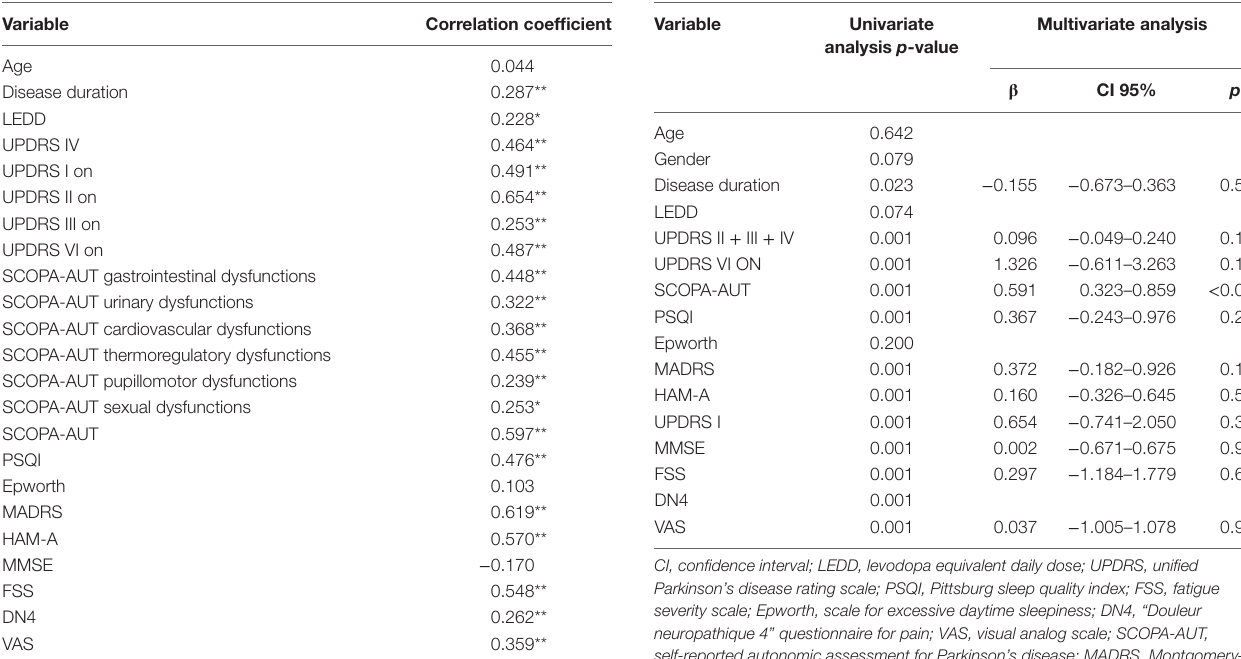
TaBle 6 | Correlation between non-motor signs and PDQ39-SI (linear regression and multiple linear regression).